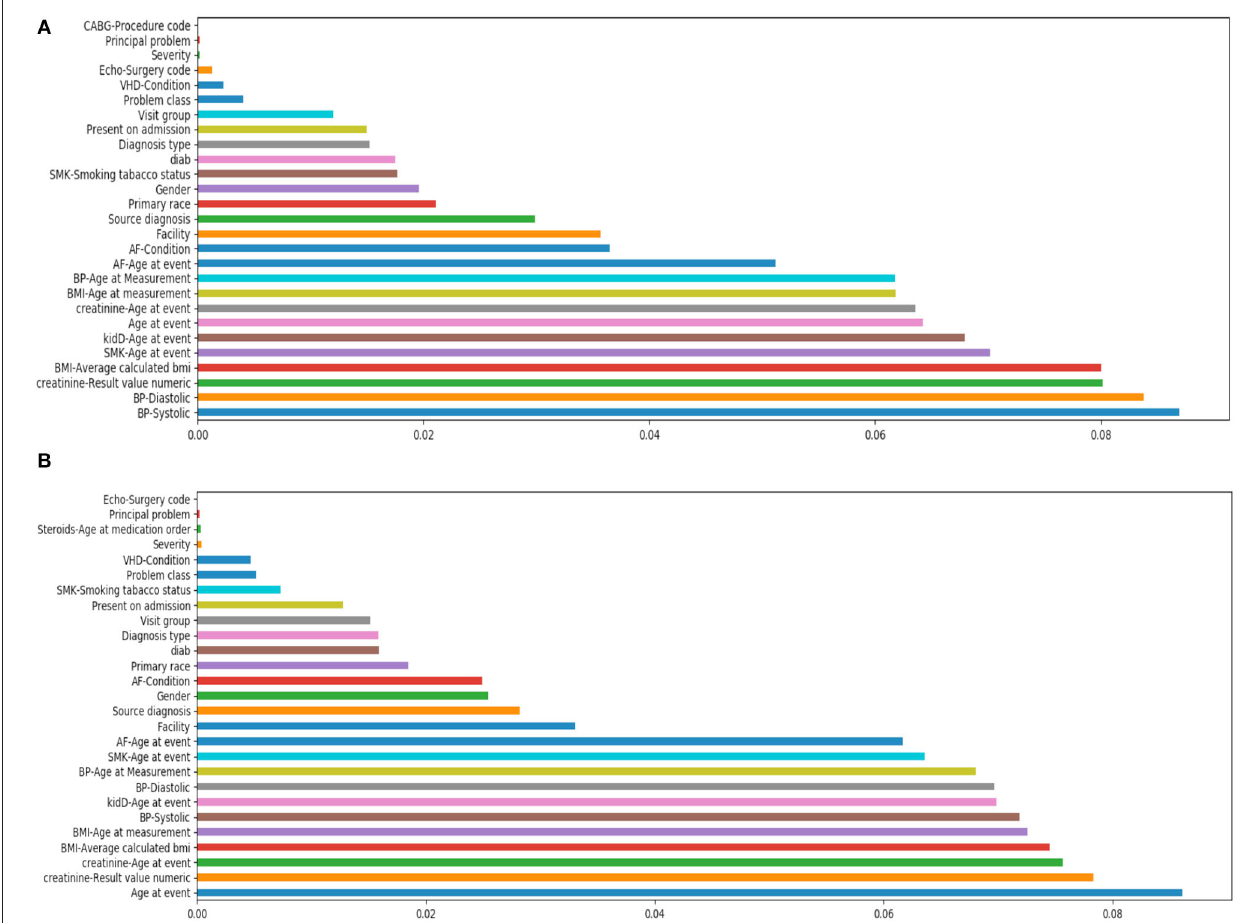
FIGURE 3 | Feature importance study by tree-based classifier. (A) Is using features after/at heart failure diagnoses date; (B) is using features prior to/at heart failure diagnoses